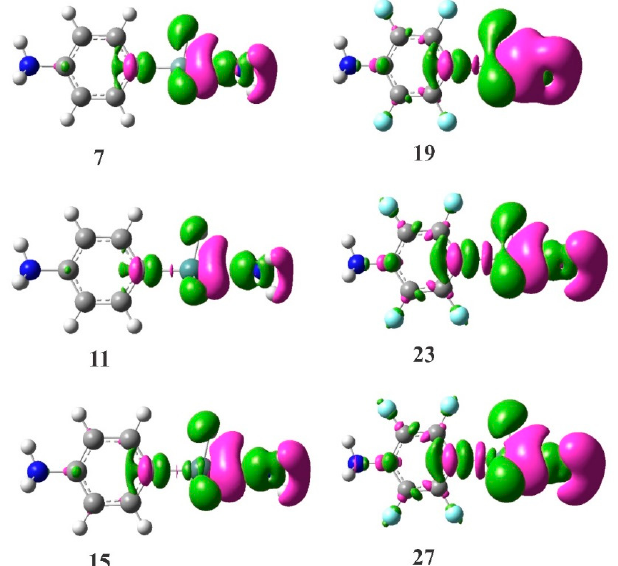
Figure 6. EDD isosurfaces (±0.001 au) of some representative cationic tetrel-bonded complexes. The violet and green regions indicate regions of decreased and increased electron densities, respectively.